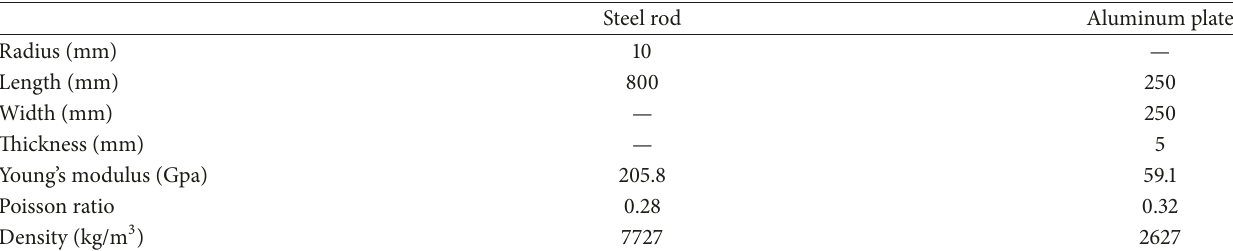
Table 1: Geometrical and material parameters.